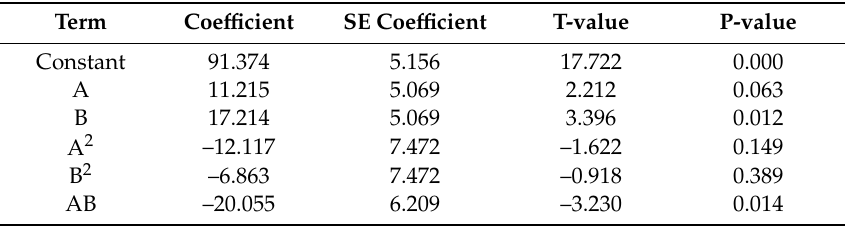
Table 3. Estimated regression coe ffi cients and ANOVA for optimization of decolorization e ffi ciency (D.E. (%)).